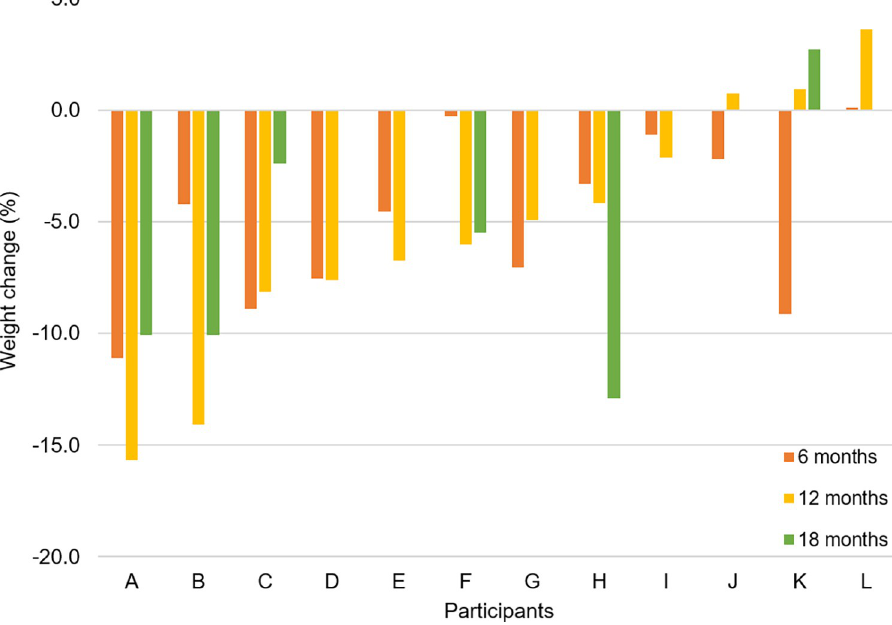
Fig 4. Weight changes (%) of each participant at six, 12, and 18 months. The data are ordered by magnitudes of weight loss at 12 months.